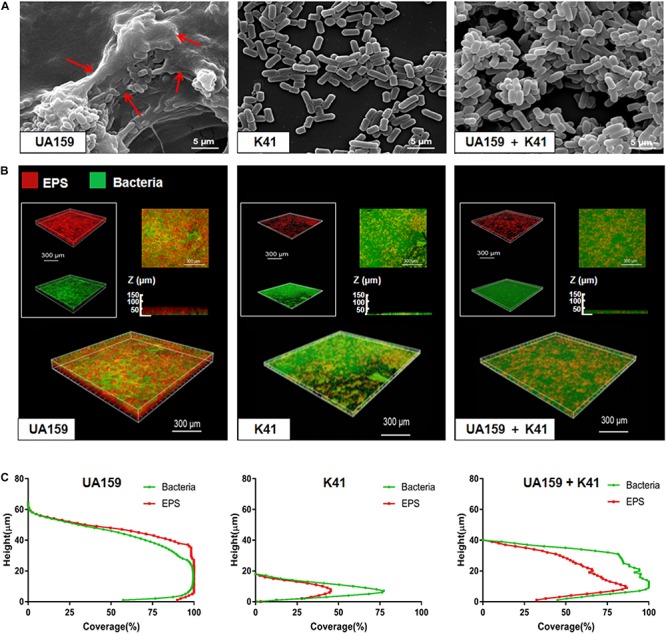
Microscope imaging of L. plantarum K41 on the S. mutans biofilm formation. (A) Scanning electron microscopy (SEM) images of the structures of different biofilms. Images were taken at 20,000× magnification. (B) EPS (red) and bacteria (green) distribution in the double-labeled biofilm was observed by confocal laser scanning microscope (CLSM). (C) The distribution of bacteria and EPS at different heights. The three-dimensional reconstruction was performed by IMARIS 7.0.0. Images were taken at 60× magnification. Red arrows in Figure 3A were the network-like structures.